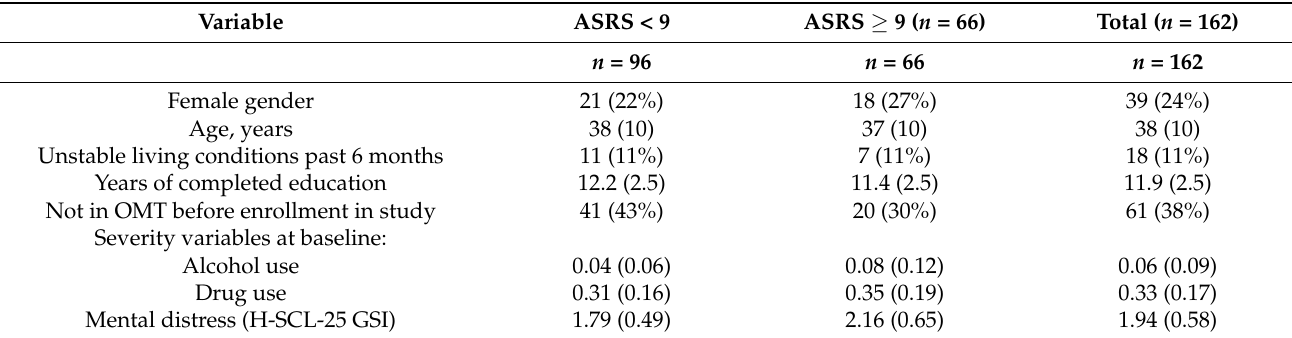
Table 1. Socio-demographic and severity variables at baseline ( n =